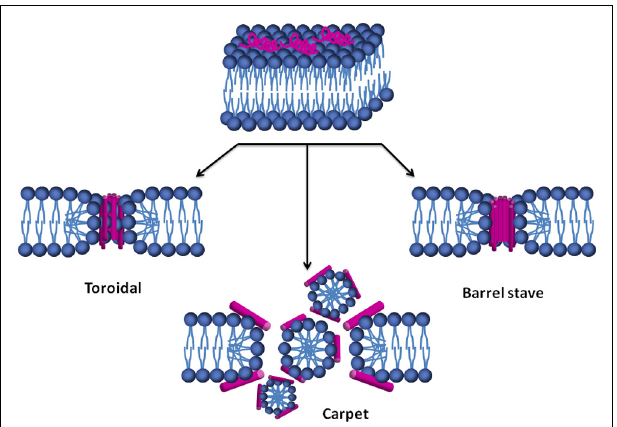
FIGURE 2 | Models of lipid membrane permeabilization byAMPs. Initially, the peptide (magenta) is adsorbed at the membrane surface. After an initial recognition of the surface, a conformational change of the peptide occurs. Once a threshold concentration of peptide on the membrane is reached, it is followed by membrane disruption by one of these three